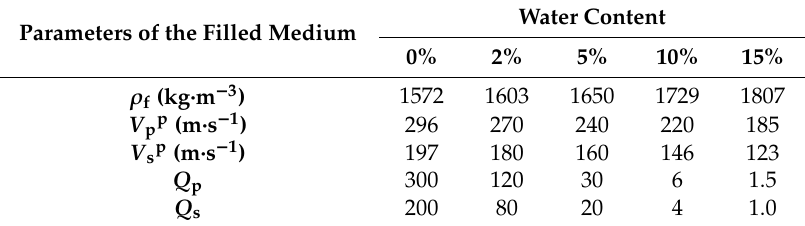
Table 1. Calibrated parameters of filled joints with di ff erent water